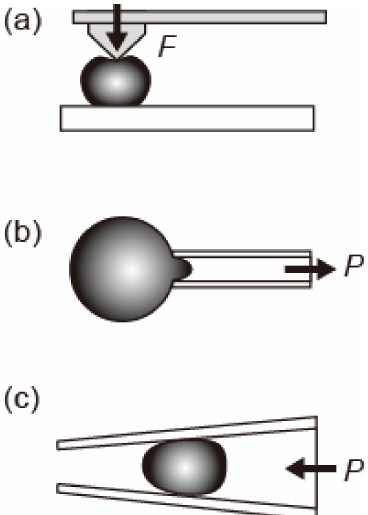
Figure 5. Schematic illustrations of methods for measuring the elastic properties of single microgels. ( a ) Atomic force microscopy (AFM) and ( b , c ) microcapillary. The single microgel is ( b ) aspirated inside the microcapillary and ( c ) deformed inside the microcapillary. The F and P represent the applied force by AFM tip and applied pressure by microcapillary,